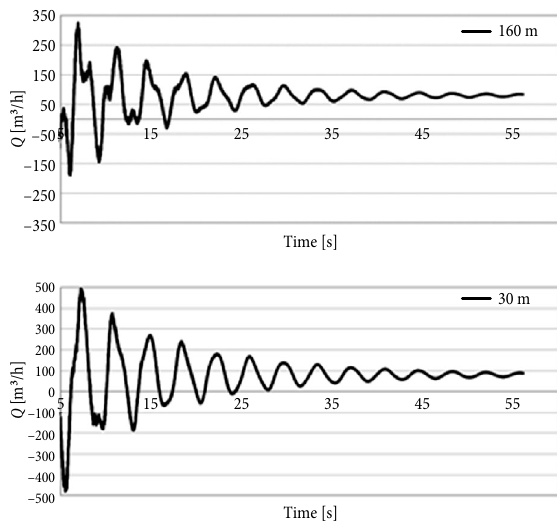
Fig. 6. Dependencies of flow variations in 1st, 10th and 16th stages of centrifugal pump over time